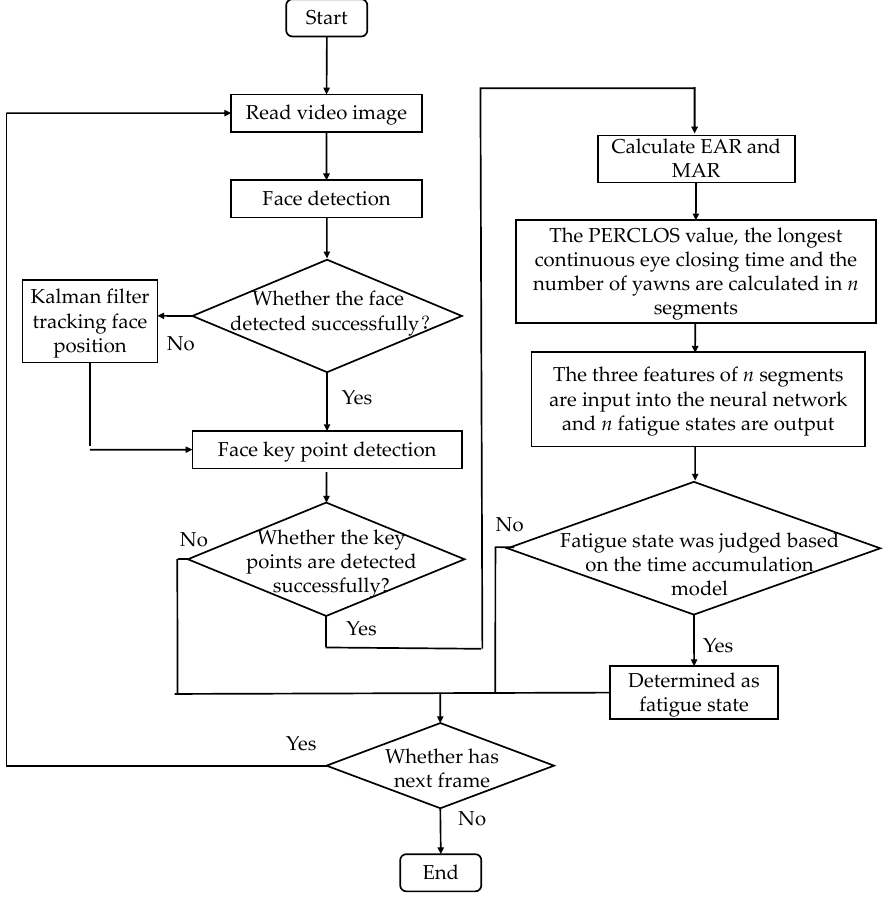
Figure 7. Flow chart of fatigue driving detection based on the time cumulative effect model.